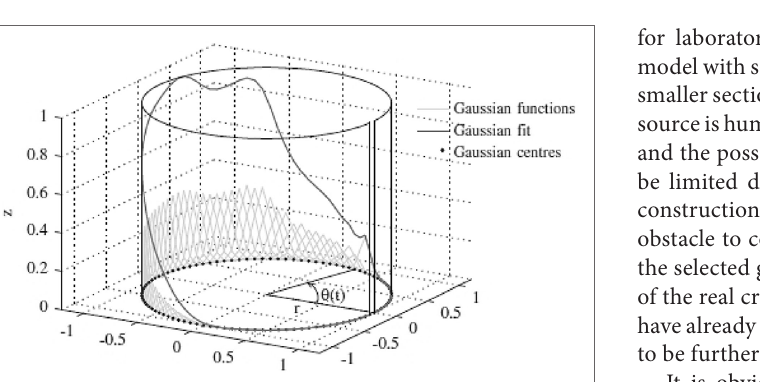
FiGURe 10 | Trajectory of Gaussians in three dimensional space. Reprinted from (Racic and Pavic, 2010b) with permission from